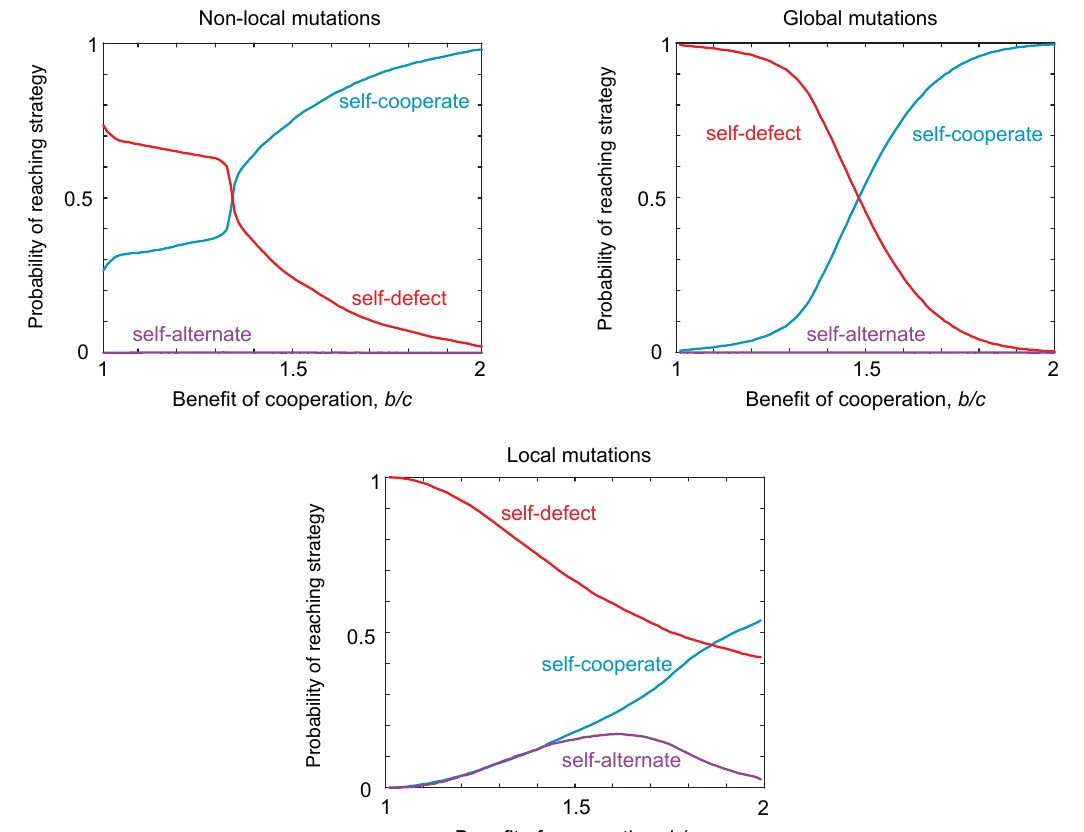
Figure 3. The probability of reaching different strategy classes under local, non-local and global mutations. We simulated populations playing an iterated public